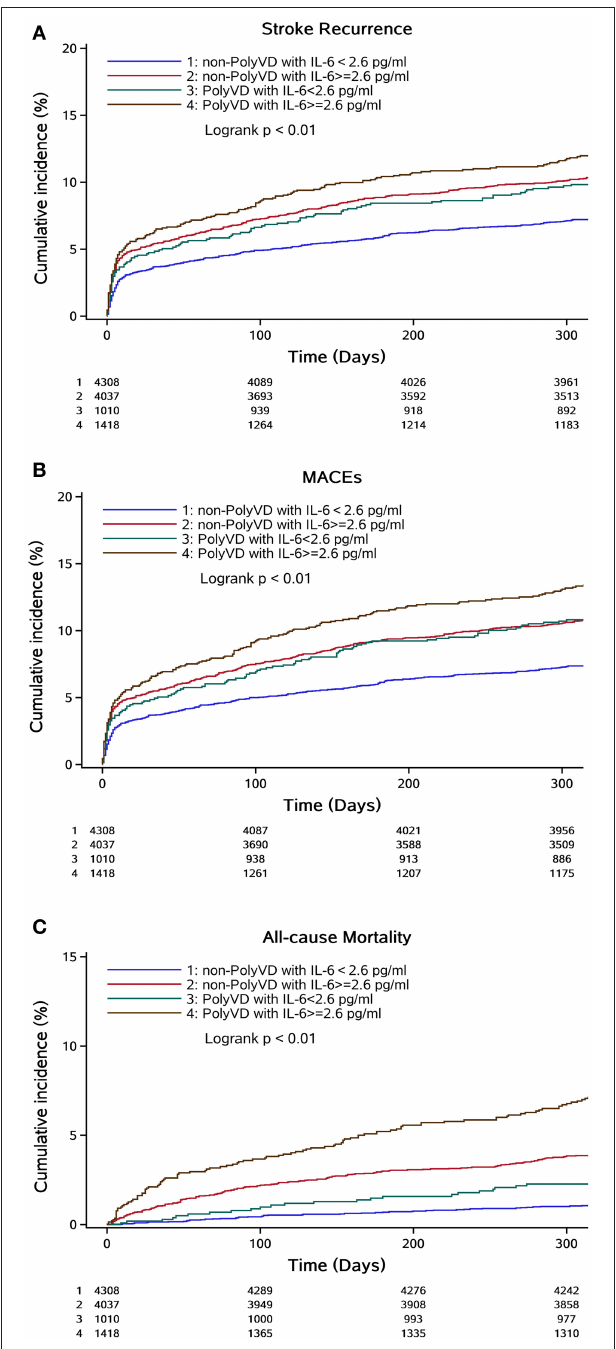
FIGURE 2 | Cumulative incidence of recurrent stroke, MACEs, and all-cause mortality at 1-year follow-up based on atherosclerosis vascular beds involvement numbers and IL-6 level. (A–C) Kaplan–Meier curves of incidence of recurrent stoke, MACEs, and all-cause mortality within 1 year, respectively.